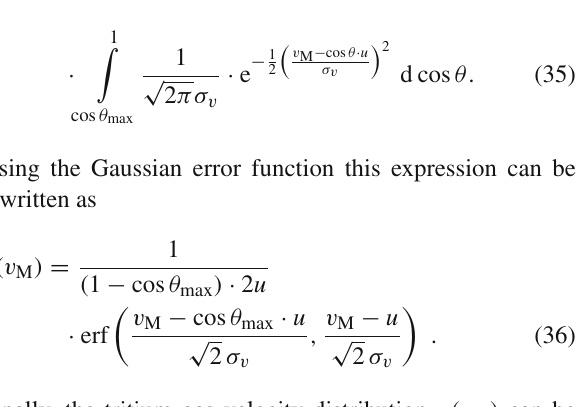
Fig. 13 Convolution kernels describing the Doppler broadening of the β spectrum due to the thermal motion and bulk velocity u of the source gas. A temperature of T bt = 30 K is assumed, leading to a Gaussian broadening with σ E ≈ 94 meV at E cms = 18 , 575